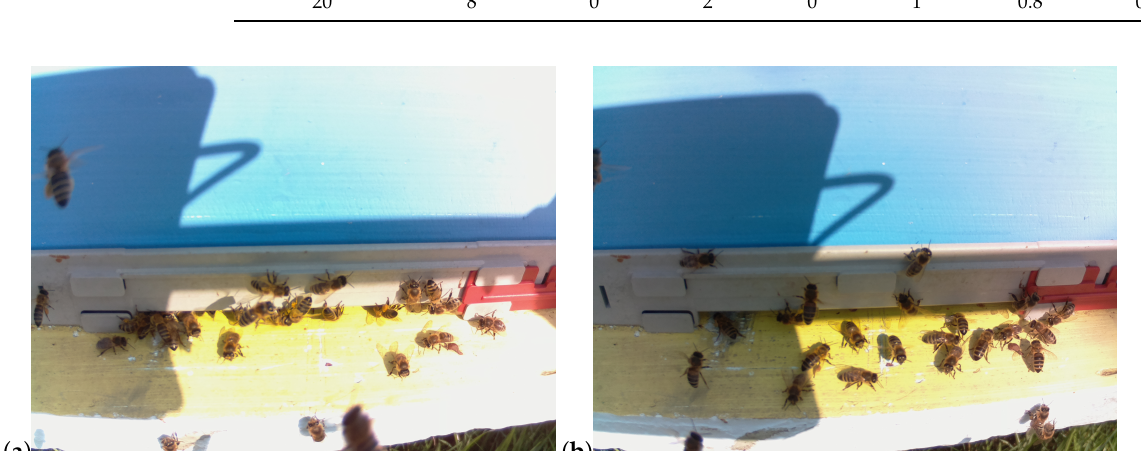
Figure 6. Images no. 7 ( a ) and no. 10 ( b